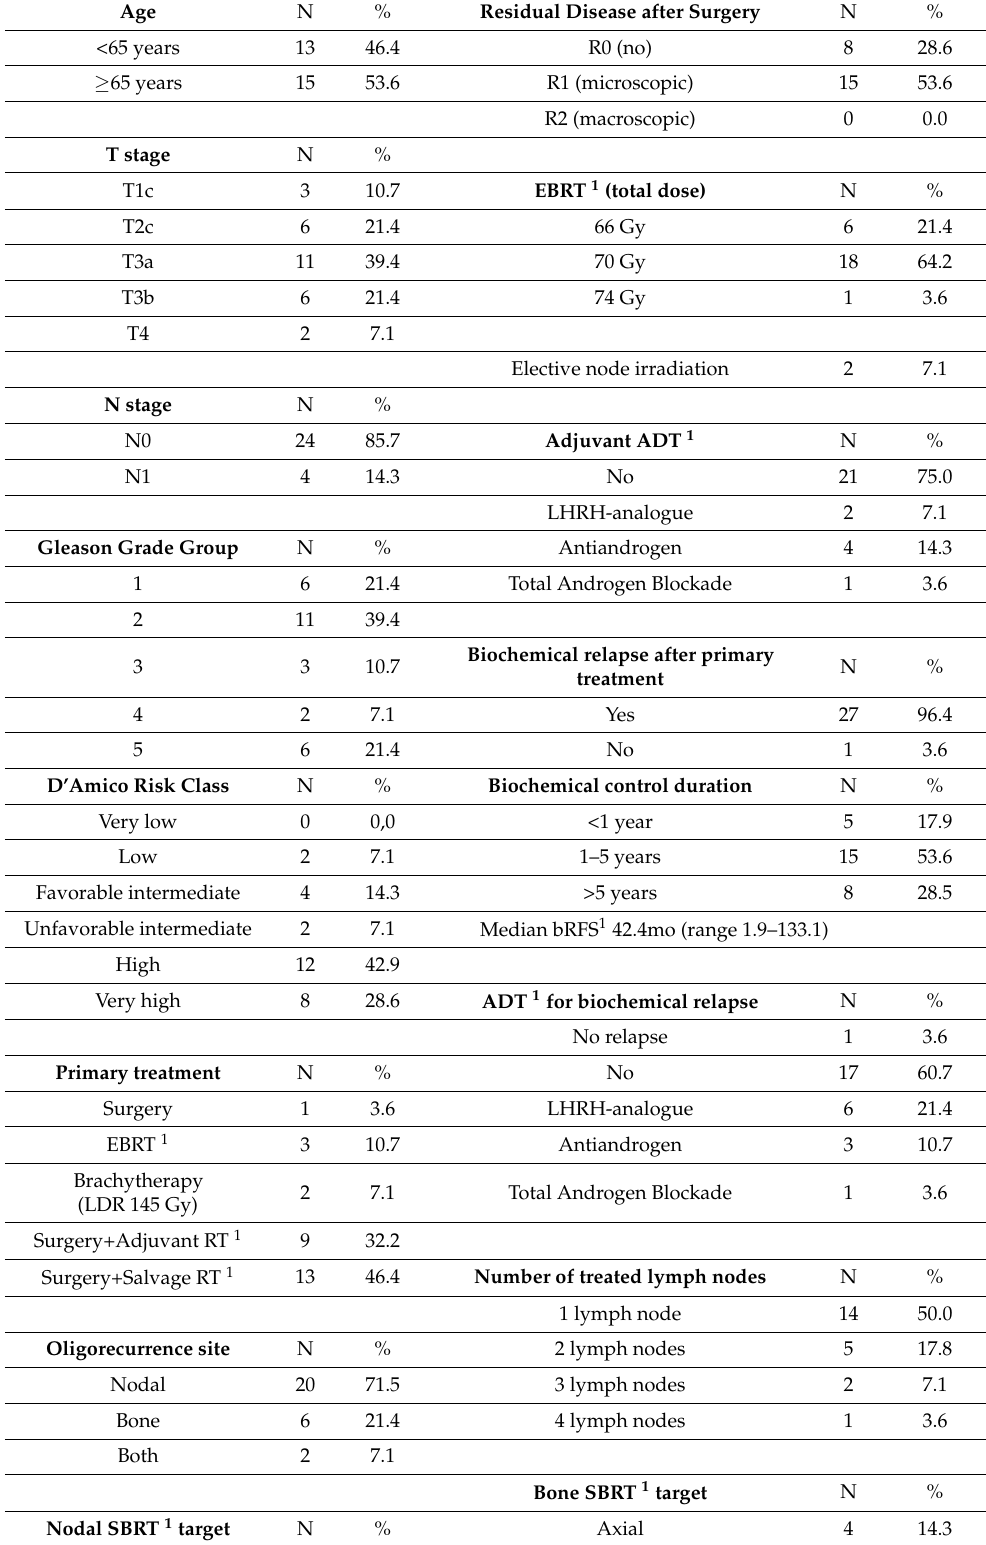
Table 3. Population